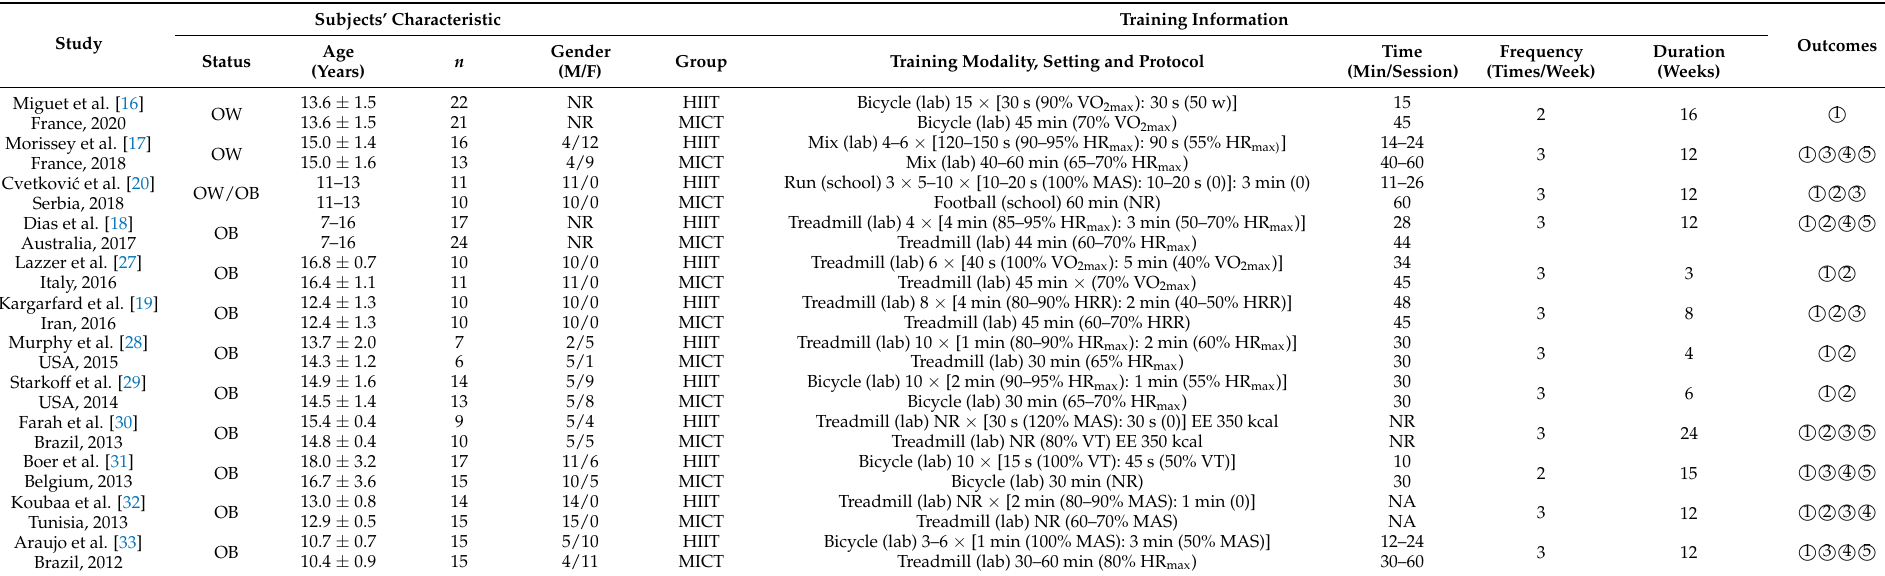
Table 1. Descriptive characteristics of the included studies of overweight and obese children and